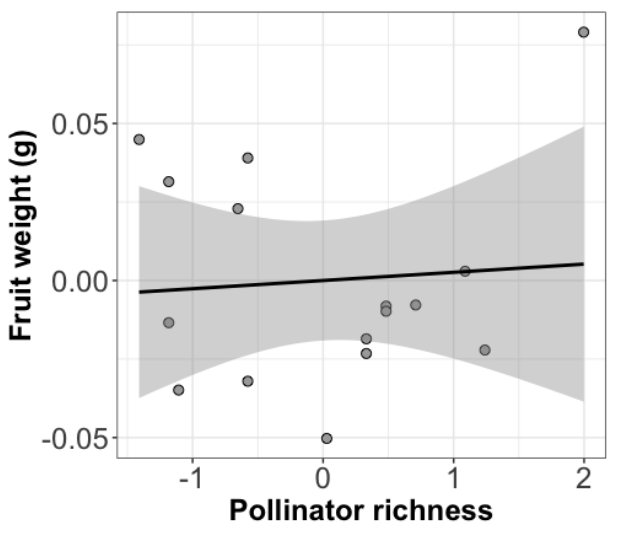
Figure S6. Partial residual plots showing the effect of pollinator richness on site-level average fruit weight. Dots represent values for each site (N=16 sites).